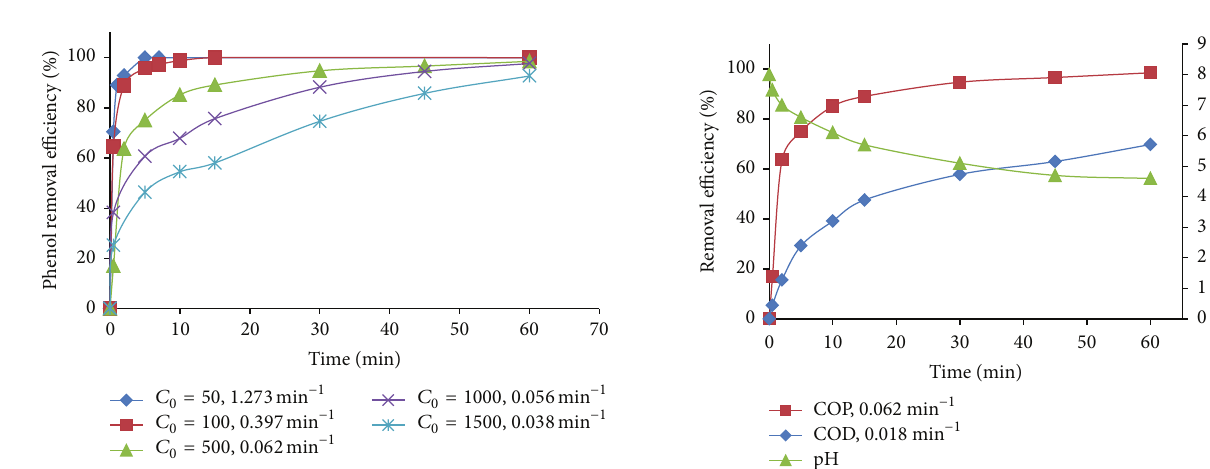
Figure 3: The degree of phenol degradation and COD removal = 500 mg/L; catalyst concentration of 2 g/L; in the COP, [phenol] o initial pH of 8